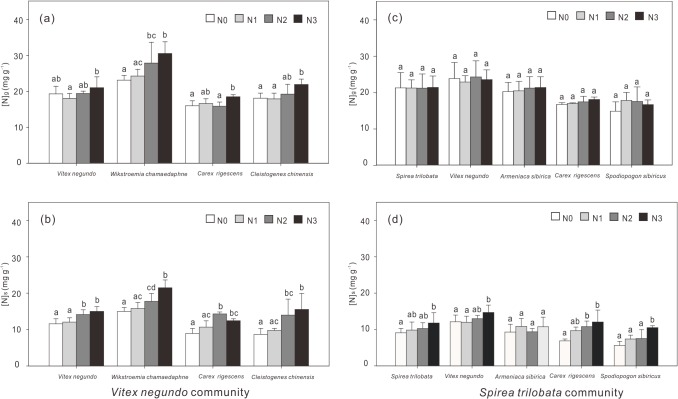
Responses of mean N concentrations in green ([N]g) and senescing leaves ([N]s) to N addition for seven dominant species in the Vitex negundo (left, a and b) and Spirea trilobata (right, c and d) communities.Error bars indicate standard deviation (n = 6). Different letters on the error bar indicate significant differences among treatments for each species based on one-way ANOVA.